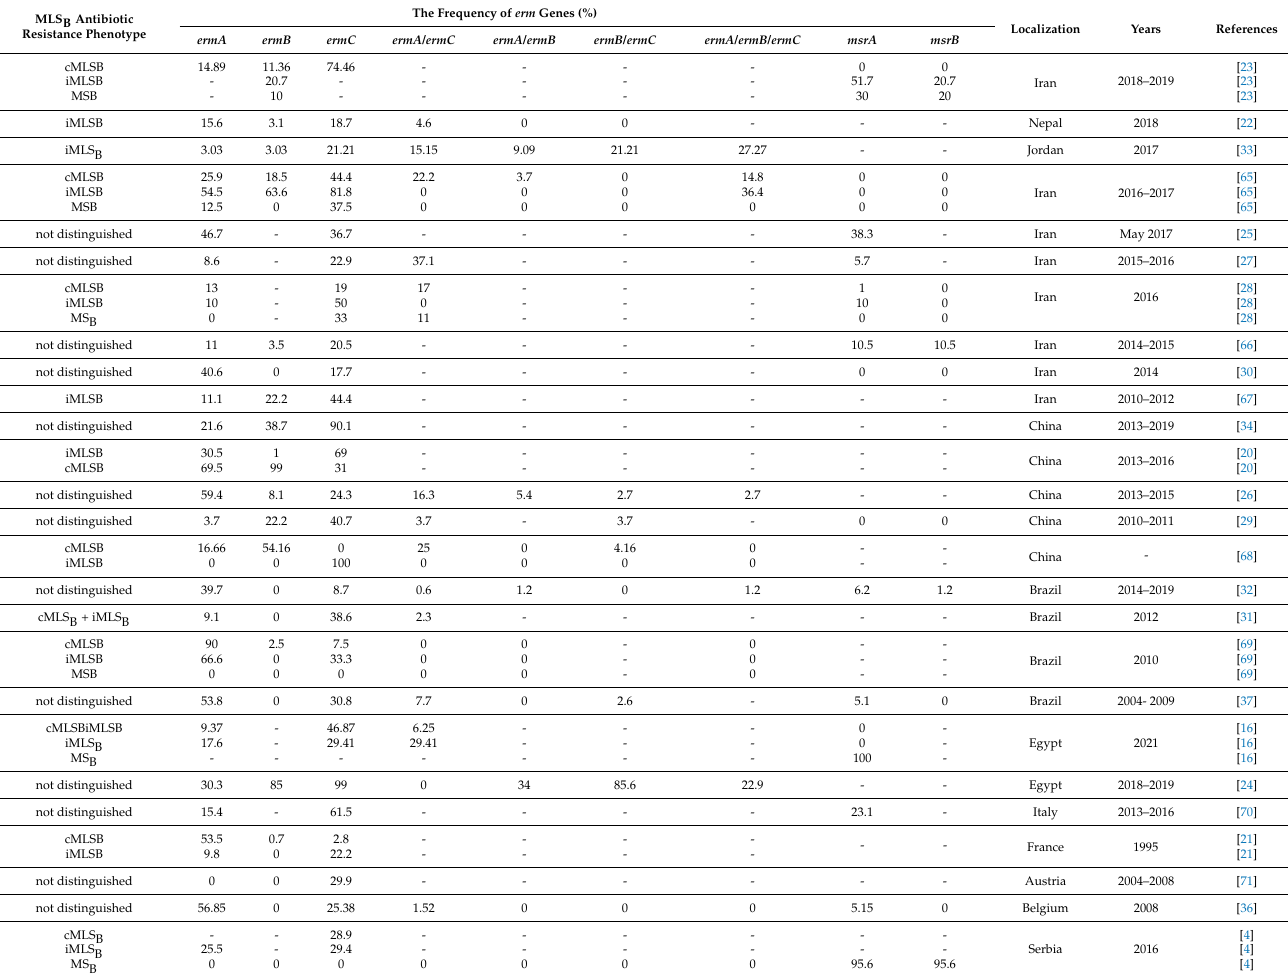
Table 3. Distribution of erm genes among MLS B -resistant S. aureus strains in various studies over the years. MLSB Antibiotic